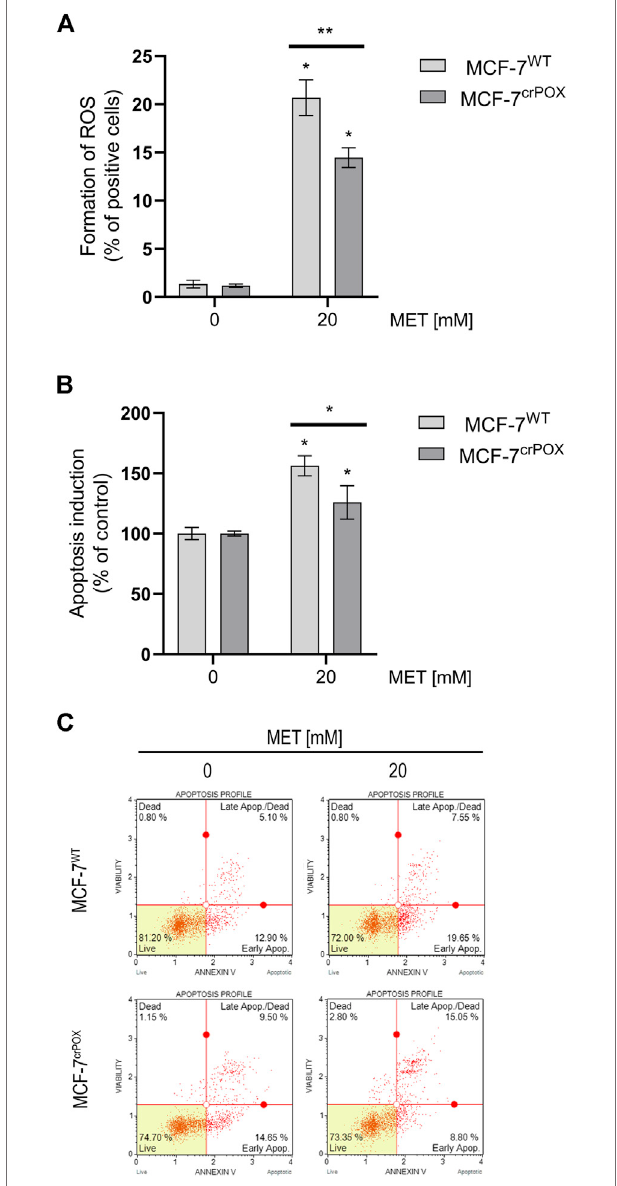
FIGURE 2 | ROS formation (A) , apoptosis induction (B) , and representativeplotsof fl ow-cytometry-basedanalysisofAnnexinV (C) inwild- type MCF-7 cells (MCF-7 WT ) and knocked-down PRODH/POX MCF-7 cells (MCF-7 crPOX )treatedwith20 mMmetformin(MET)for48 hinglutamine- free medium. The mean values with standard deviation (SD) from three experiments performed in duplicates are presented. Asterisks (*) indicate statisticaldifferences between studied cells compared tocontrolsat * p < 0.01 and ** p < 0.001.